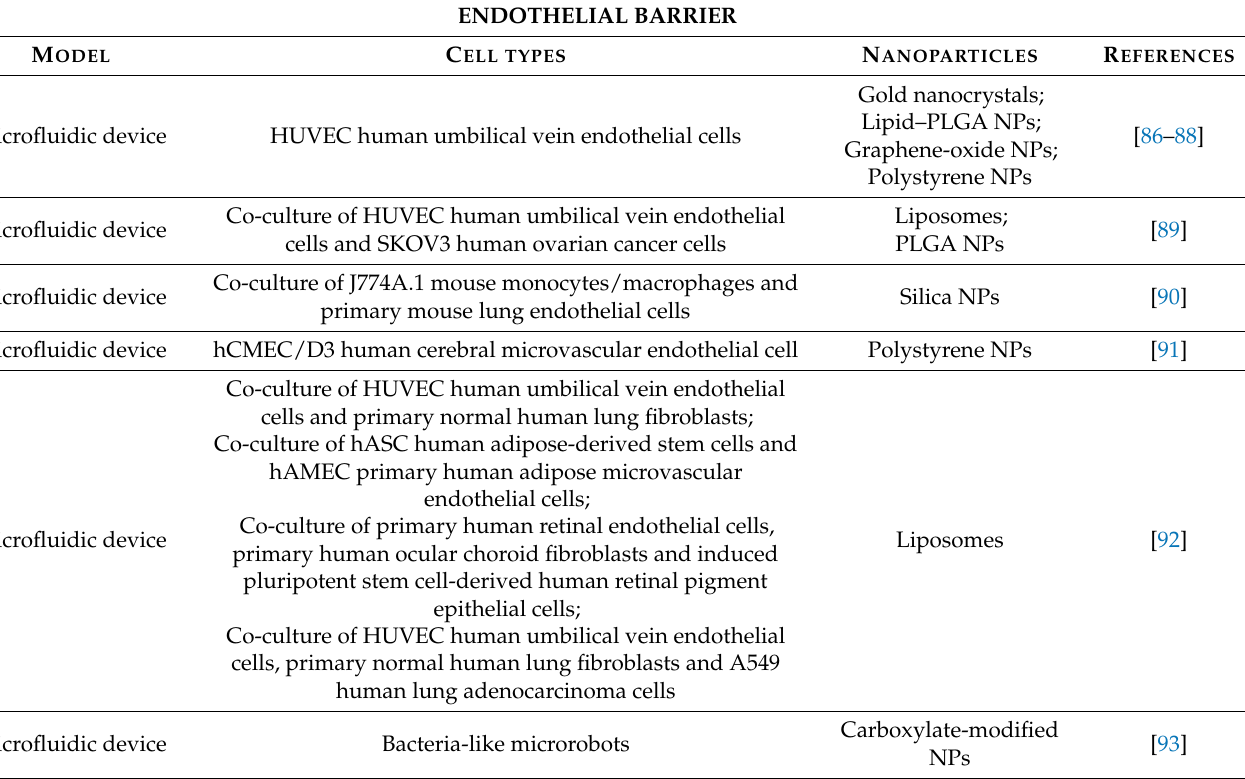
Table 3. Summary of in vitro endothelial barrier models used for nanomedical studies. ENDOTHELIAL